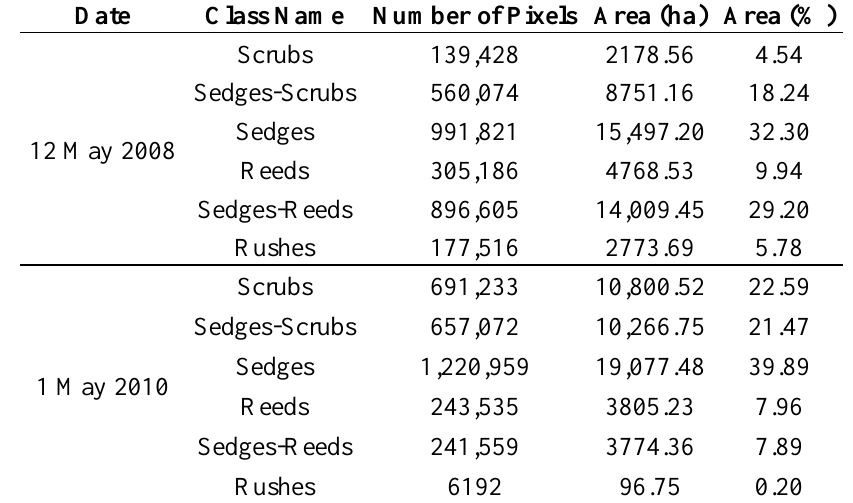
Table 4. The number of pixels and area in hectares and in percentage of each class.